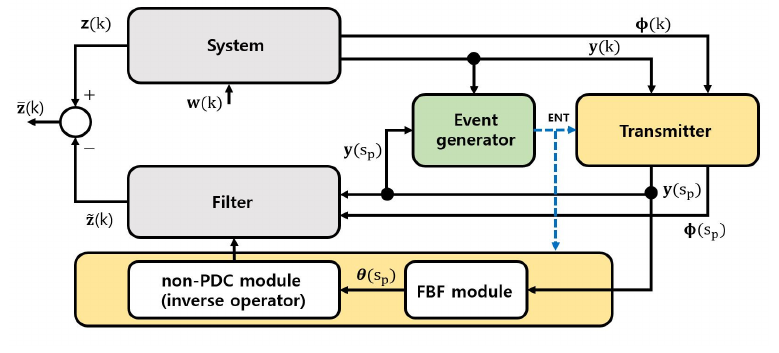
Figure 1. Block diagram of the entire system under our